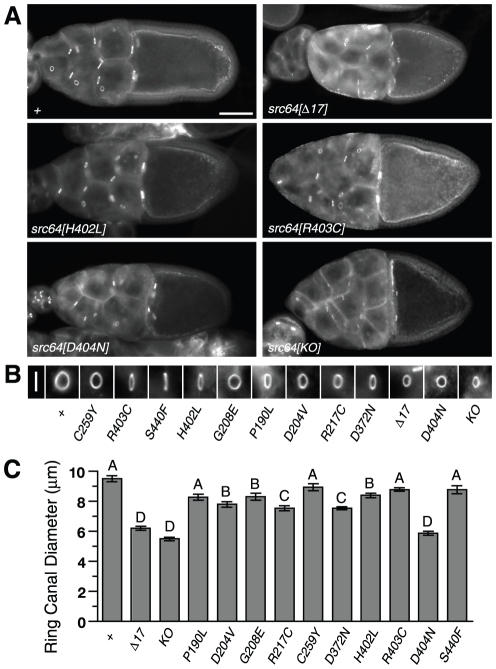
Ring canal growth defects in src64 mutant egg chambers.Ring canals are stained with antibody to HTS. (A) Egg chambers. Ring canal diameters are reduced in the src64Δ17, src64H402L, src64D404N and src64KO mutants. Scale bar, 50 µm. (B) Typical ring canals ordered mean by diameter and oriented so diameter is presented along the vertical axis. Scale bar, 10 µm. (C) Ring canal diameters. A, does not differ from +; B, differs from + (P<0.05), but not other A alleles, except src64D204V differs from src64R403C (P<0.05); C, differs from + (P<0.001) and from A alleles (P<0.05) except src64P190L, but not from group B, except src64D372N differs from src64H402L (P<0.01); D, does not differ from src64KO, but differs from all other alleles (P<0.001). Error bars are SEM.